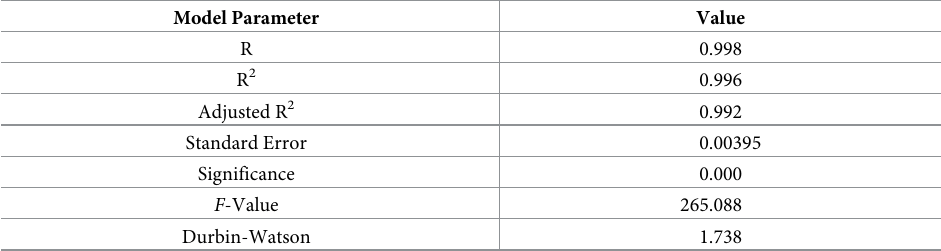
Table 9. Results of stepwise multiple linear regression for schedule performance in reconstruction